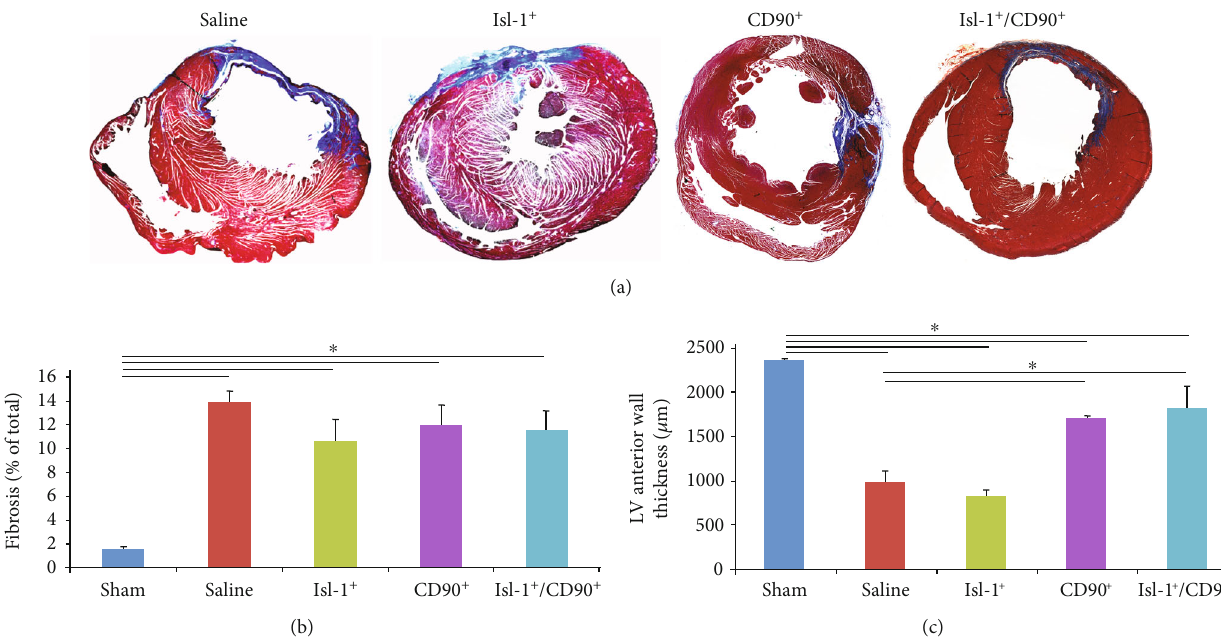
Figure 3: Combination of Isl-1 + cells/CD90 + cells preserves wall thickness. (a) Masson ’ s trichrome staining was used to stain the fi brotic tissue in blue. Representative bright fi eld microscopy images of 4-week post-MI rat hearts are shown. Fibrosis is limited to the anterior wall of the left ventricle. (b) Quanti fi cation of fi brosis revealed that none of the cell treatments was able to signi fi cantly reduce fi brosis (saline: 13 : 85 % ± 0 : 96 vs. Isl-1 + : 10 : 69 % ± 1 : 77 , p = 0 : 14 ; saline vs. CD90 + : 11 : 95 % ± 1 : 61 , p = 0 : 22 ; saline vs. Isl-1 + /CD90 + : 11 : 62 % ± 1 : 55 , p = 0 : 19 ). The combination of Isl-1 + cells and CD90 + cell treatment was su ffi cient to maintain wall thickness (sham: 2354 : 39 μ m ± 18 : 03